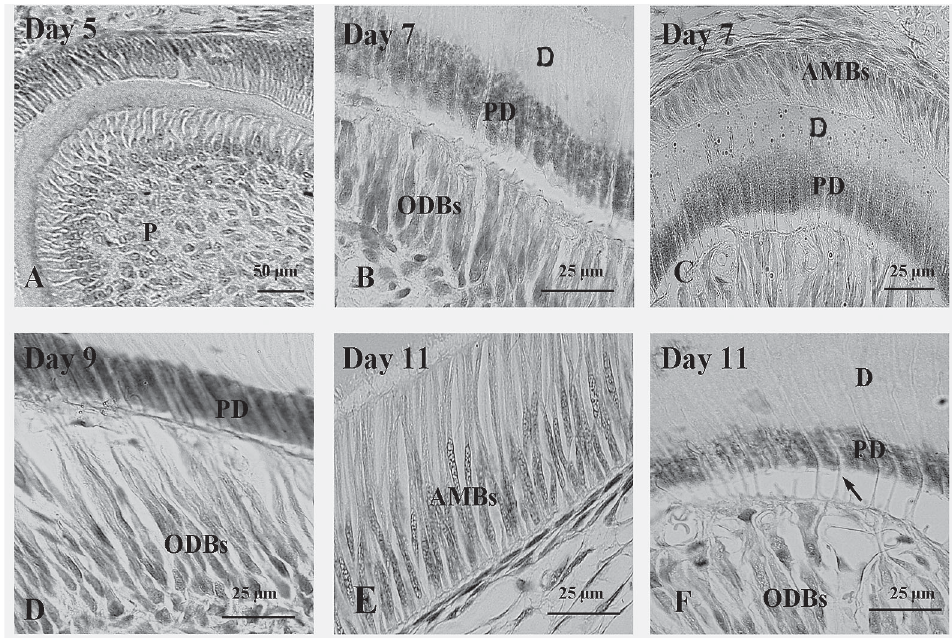
Figure 2. Immunocytochemical detection of decorin in dental germs of rats aged 5-11 days. On day 5, the immunoreaction is very weak in predentin (A). On day 7, a strong reactivity is ob- served in predentin (B). Another view showing the absence of immunoreactivity observed in ameloblasts (C). On day 9, the immunoreaction is not observed in odontoblasts, whereas it is strong in predentin (D). On day 11, ameloblasts continue to be negative (E). Another view of the 11th day showing a decrease in the reactivity in predentin (F). AMBs - ameloblasts; arrow - odontoblastic process; D - den- tin; ODBs - odontoblasts; P - pulp; PD -